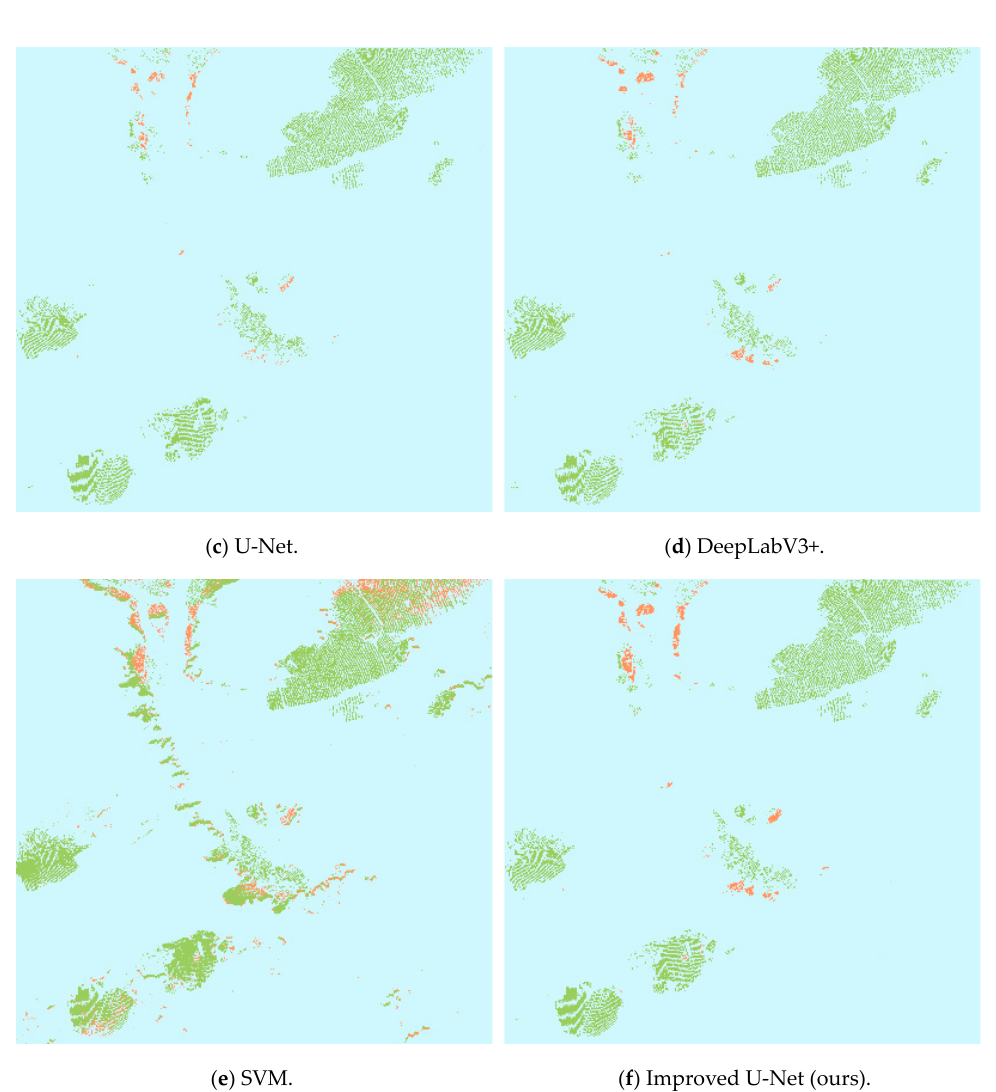
Figure 5. The extraction results of the floating raft aquaculture area and the cage aquaculture area on the test image (as the left part of the test area is all land and there is no aquaculture area, this area has been removed): ( a ) test image; ( b ) ground truth; ( c ) original U-Net; ( d ) DeepLabV3+; ( e ) SVM; ( f ) improved U-Net. The orange area in the figure represents the cage aquaculture area; the green area represents the floating raft aquaculture area; and the blue area represents the background.